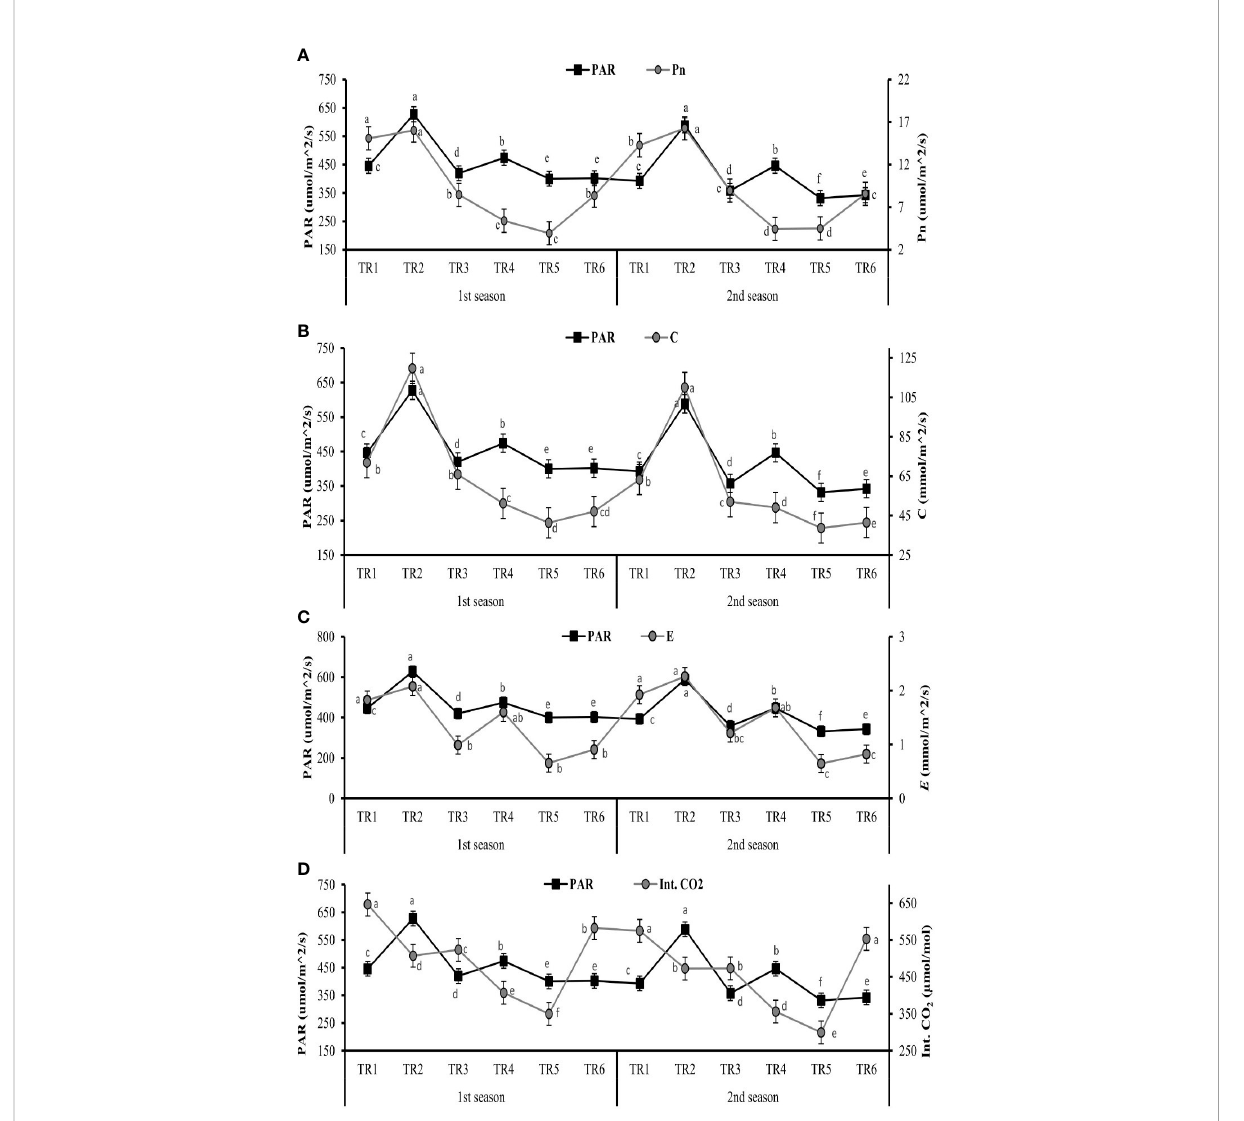
FIGURE 1 Effect of different treatments on (A) Pn (net photosynthesis), (B) C (stomatal conductance), (C) E (transpiration rate), and (D) Int. CO2 (internal carbon dioxide) in leaves and impact of photosynthetic active radiation on these physiological features of C. sativum after anthesis under drought regimes. The graph values are the mean ± SE of four replicates. Bars exhibited with different alphabets indicate the signi fi cant difference between samples by least signi fi cant difference (p ≤ 0.05). TR1: FI, TR2: FI + ZnO nanoparticles (NPs), TR3: MDR, TRT4: MDR + ZnO NPs, TRT5: IDR, and T6: IDR + ZnO